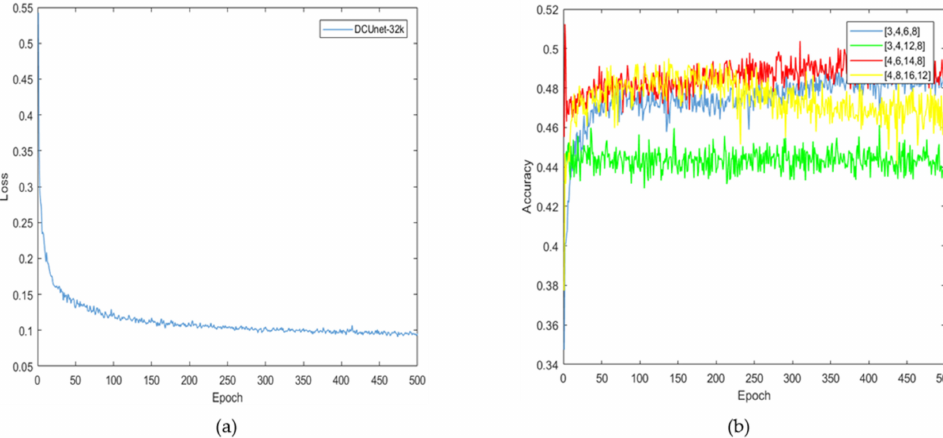
Figure 7. The learning process and the experimental results of the model: ( a ) the loss function of the proposed algorithm; ( b ) the results of different micro